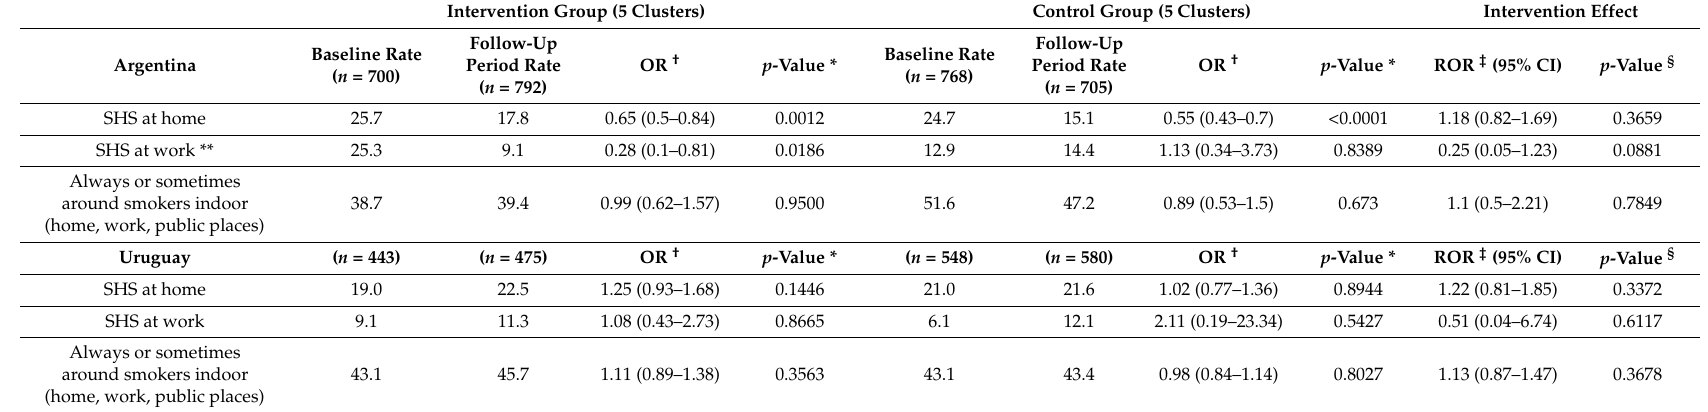
Table 2. Effect of intervention on secondhand smoke exposure on non-smokers and quitters in Argentina and